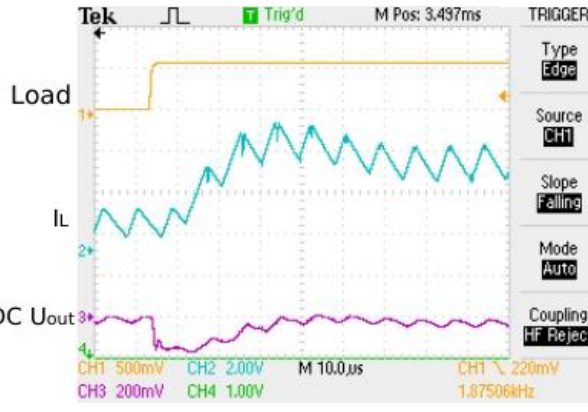
Figure 11. Step increase in output